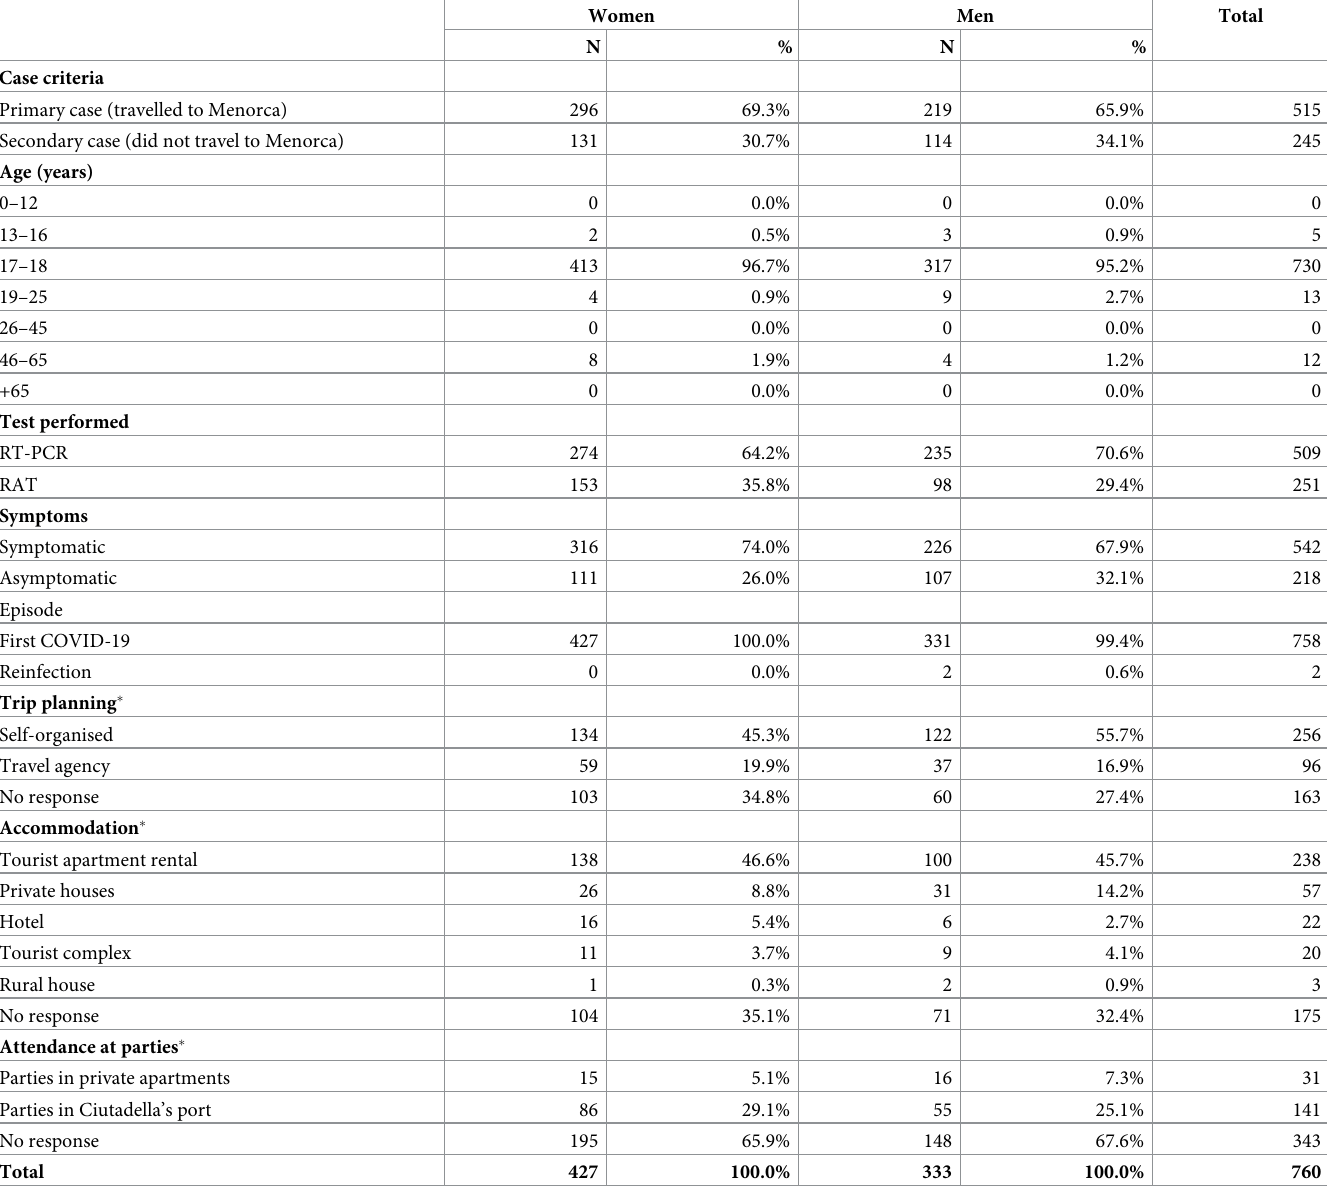
Table 3. Description of confirmed cases and exposure in the Menorca trip outbreak of SARS-CoV-2. Catalonia, June, and July of